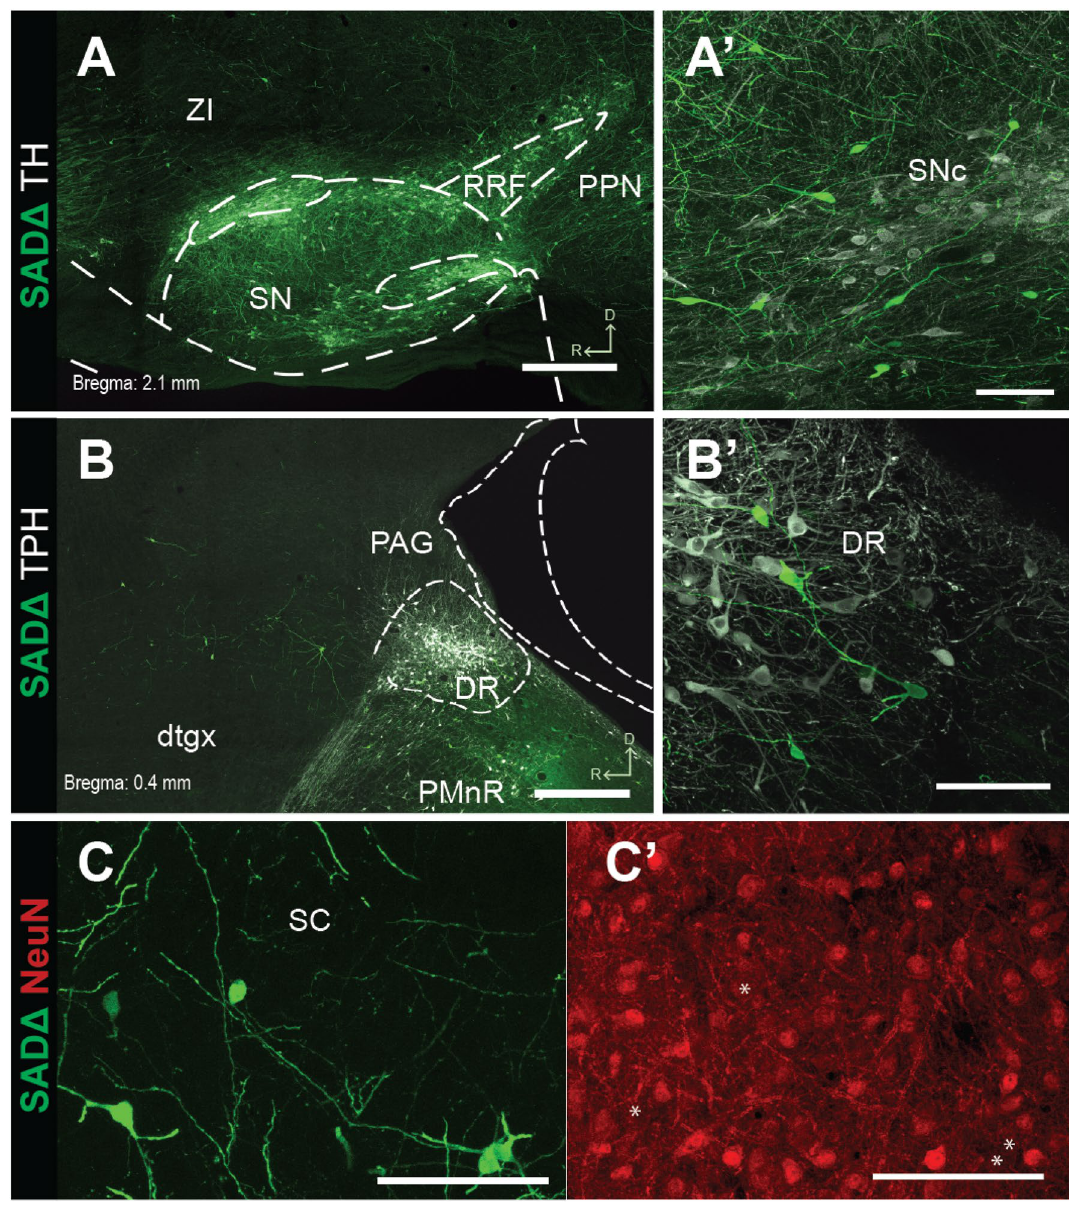
Figure 6. Neurochemical characterization of input neurons in the substantia nigra compacta and dorsal raphe. ( A ) Input neurons located within the borders of the SNc after injections in the PPN and LDT were immunolabeled with a TH antibody to identify dopaminergic neurons. In all cases, input neurons were immunonegative, despite being closely intermingled with TH + neurons ( A ′ ). ( B ) Input neurons located within the borders of the DR after injections in the LDT were immunolabeled with a TPH antibody to identify serotonergic neurons. In all cases, input neurons were immunonegative, despite being closely intermingled with TPH2 + neurons ( B ′ ). ( C ) Input neurons located in the superior colliculus (SC) were incubated with NeuN antibodies to detect the presence of this ubiquitous neuronal protein. ( C ′ ) SC input neurons were immunonegative for NeuN, thus confirming the limitations of immunohistochemical detection of neuronal markers in rabies-infected neurons. Scale bars: ( A ) and ( B )500 µm; ( A ′ ), ( B ′ ) and ( C ) 100